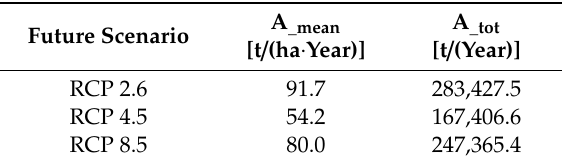
Figure 9. Guerna catchment: map of computed soil loss (A) considering future scenarios RCP 2.6, RCP 4.5, RCP 8.5 and using RUSLE method. RCP: Representative Concentration Pathways. Table 7. Computed soil loss (Revised Universal Soil Loss Equation (RUSLE) method) considering di ff erent future